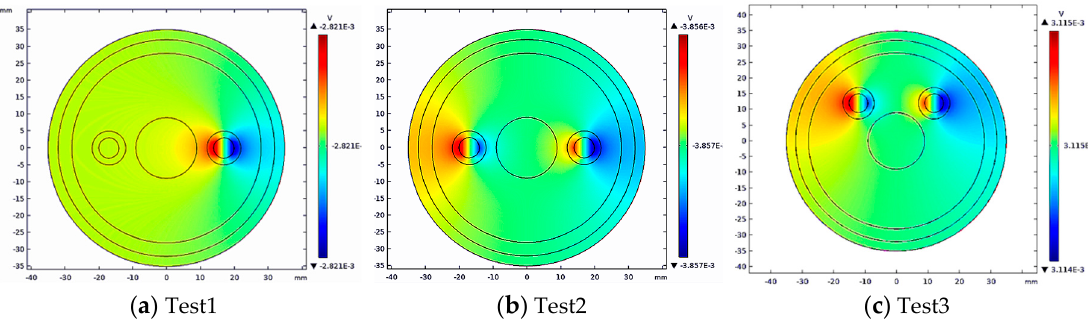
Figure 7. The induction potential distribution of the measured section in different test conditions.